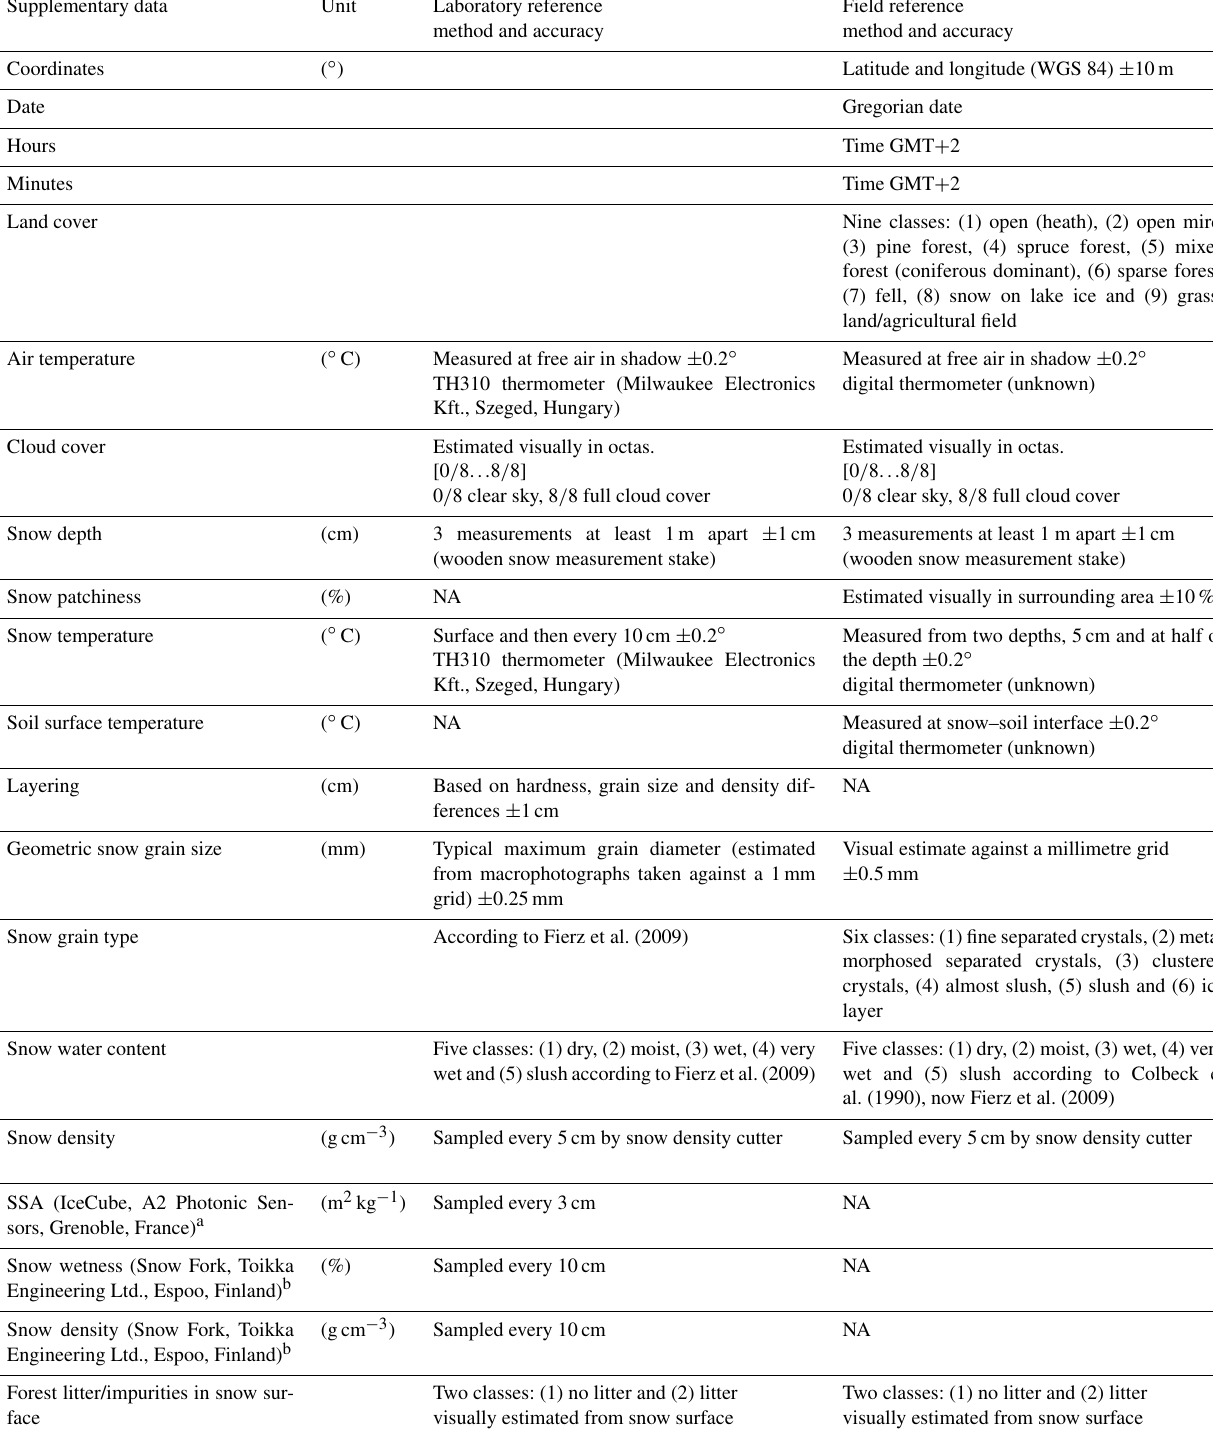
Table 3. Supplementary parameters measured from each snow type condition represented in the portable field measurements and in the snow laboratory